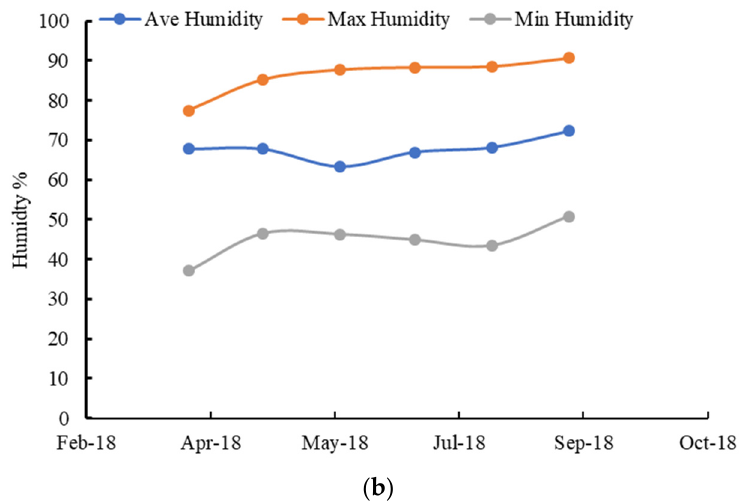
Figure 3. Outdoor environmental changes. ( a ) Average temperature and precipitation. ( b ) Humidity data.